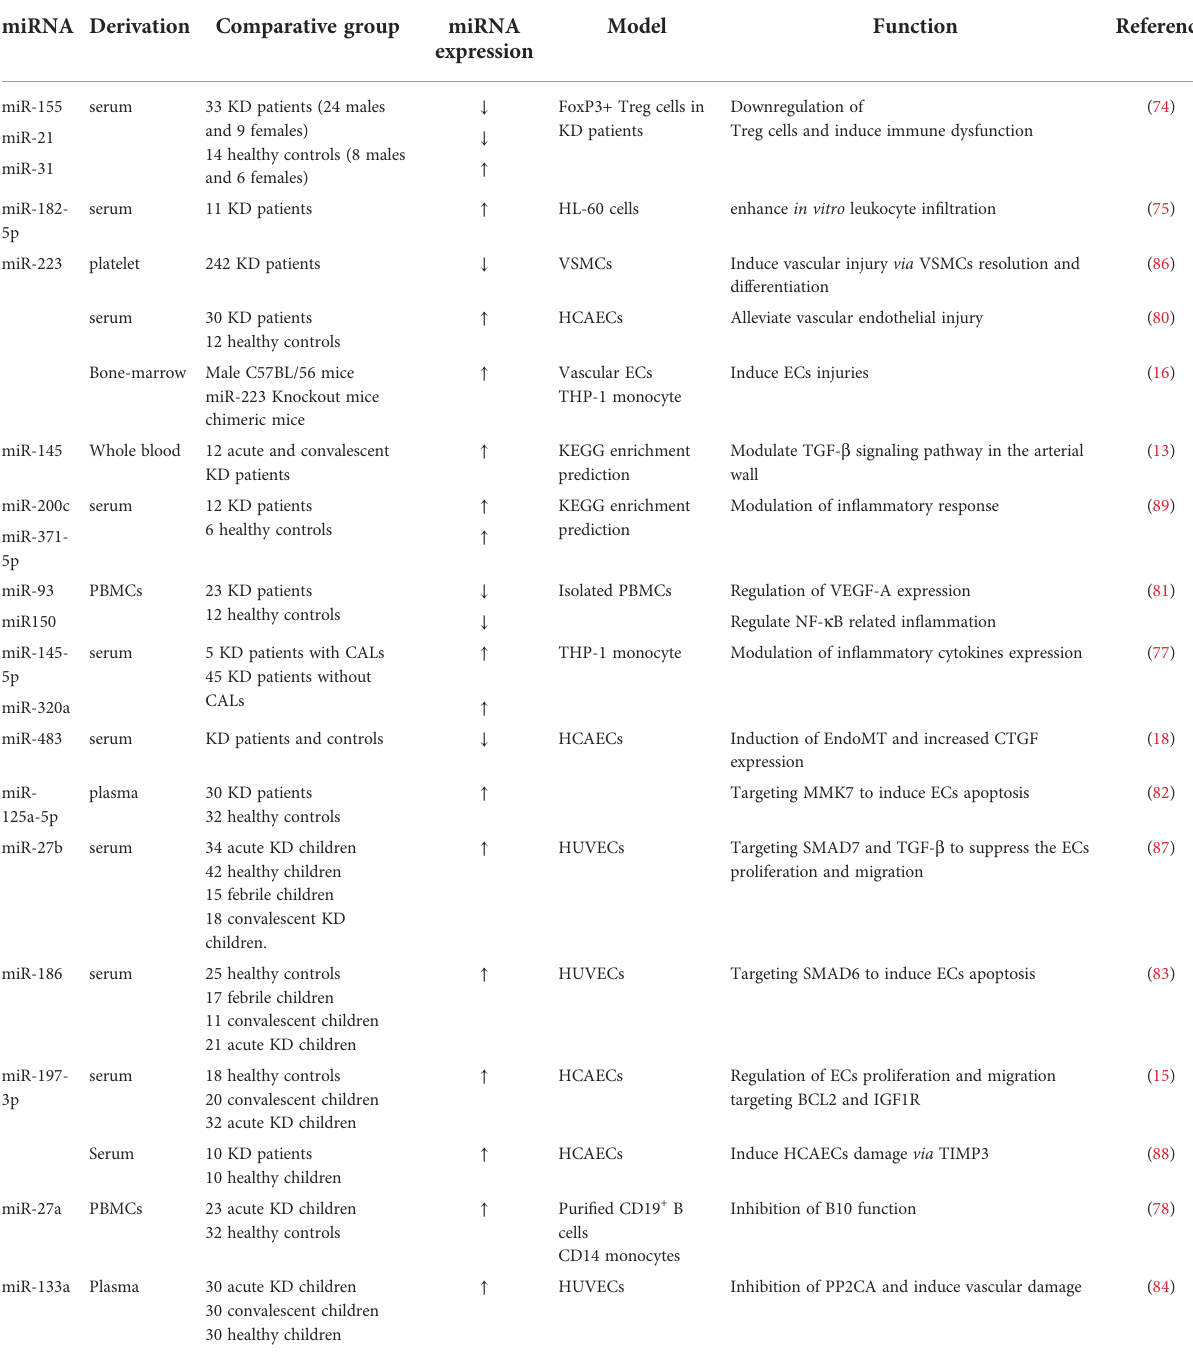
TABLE 1 The role of miRNAs in regulation of KD mechanism. miRNA